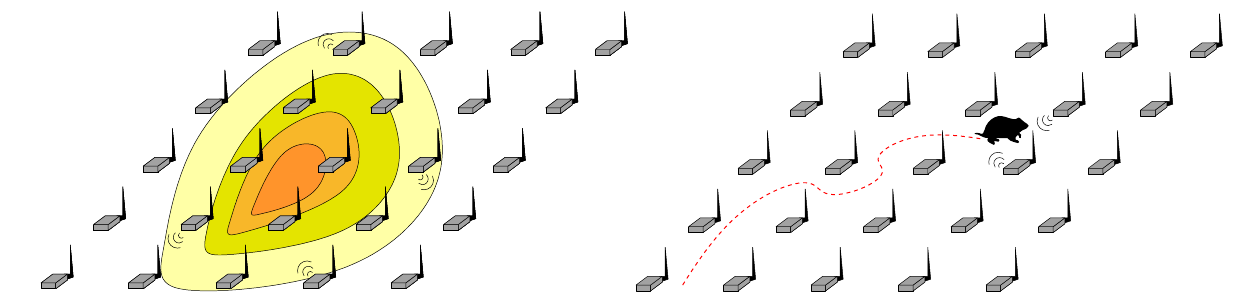
Figure 1. Application examples: the range and severity of toxic fumes may be approximated using selected sensors (left graph), the movement of an animal may be reconstructed by analyzing historical data collected by sensors (right